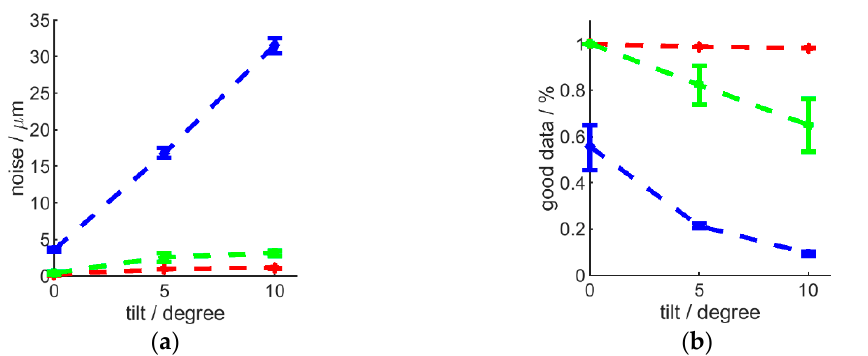
Figure 13. the combined effect of sample tilt and vibration on noise ( a ) and data quality ( b ); vibrations: 0 Hz, 0 µm (red); 10 Hz, 10 µm (green); 100 Hz, 10 µm (blue); the standard deviation is shown by the error bars.